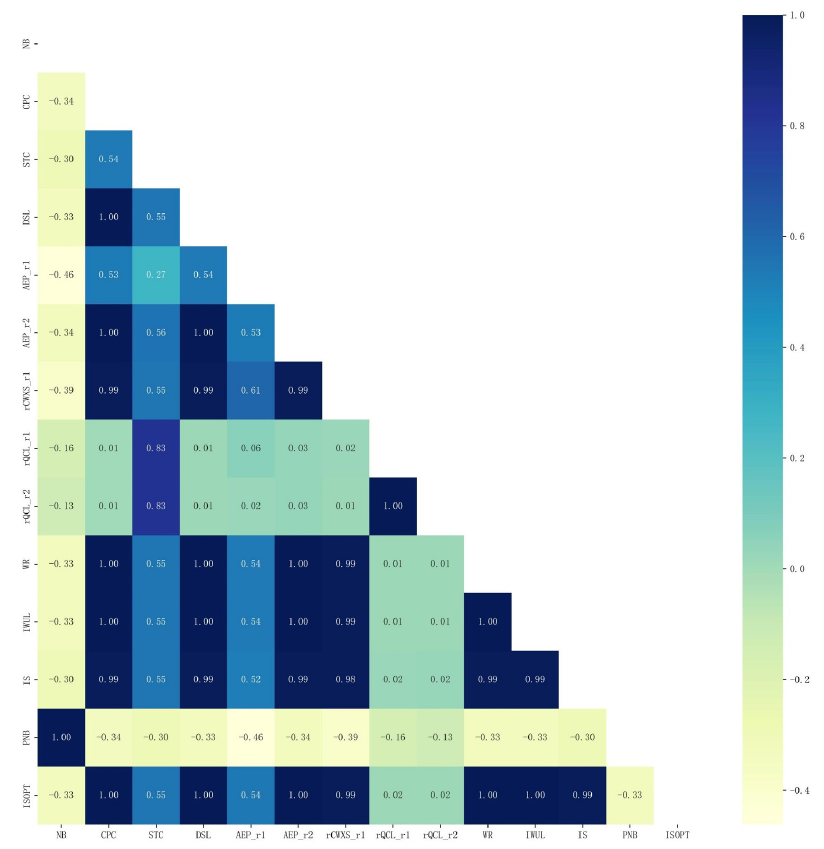
Figure 6. Correlation of variables in the industrial sector IFTSC model.